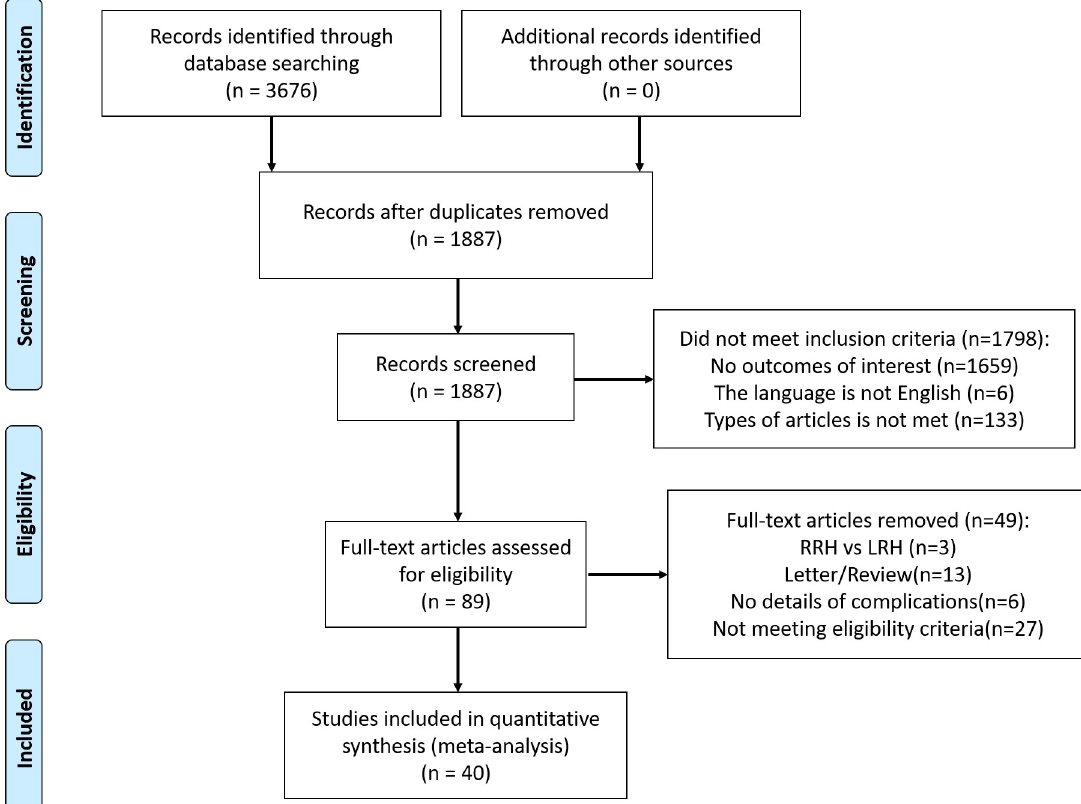
Fig 1. Flow chart of study selection in this